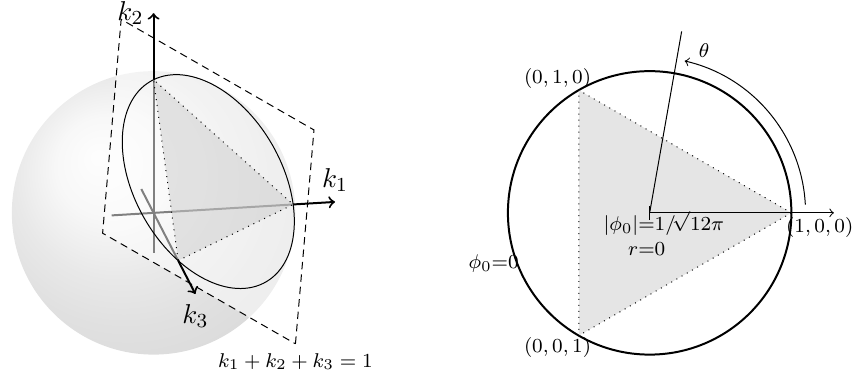
Figure 1 . Kasner exponents allowed by the constraints. The condition Tr K ± = 1 restricts 6 1 eigenvalues k 1 ± , k 2 ± , k 3 ± of K ± to a plane. The Hamiltonian constraint Tr K 2 = 1 − 8 πφ 2 ± 0 ± restricts them to the shaded ball, specifically to a sphere of radius controlled by φ 0 ± . The plane and ball intersect along the Kasner disk, depicted on the right, which is conveniently parametrized by √ the Kasner radius r ( φ 0 ± ) and angle θ . The center of the disk is K ± = 1 δ , for which φ 0 ± = 1 / 12 π . 3 More generally, r ( φ 0 ± ) 2 = 1 − 12 πφ 2 . We also shade the Kasner triangle, subset of the disk in which 0 ± all Kasner exponents are positive. Its corners are ( k 1 ± , k 2 ± , k 3 ± ) = (1 , 0 , 0) and permutations thereof. to lie in a circle (with a φ -dependent radius r ( φ ) ), which we parametrize by a 0 − 0 −